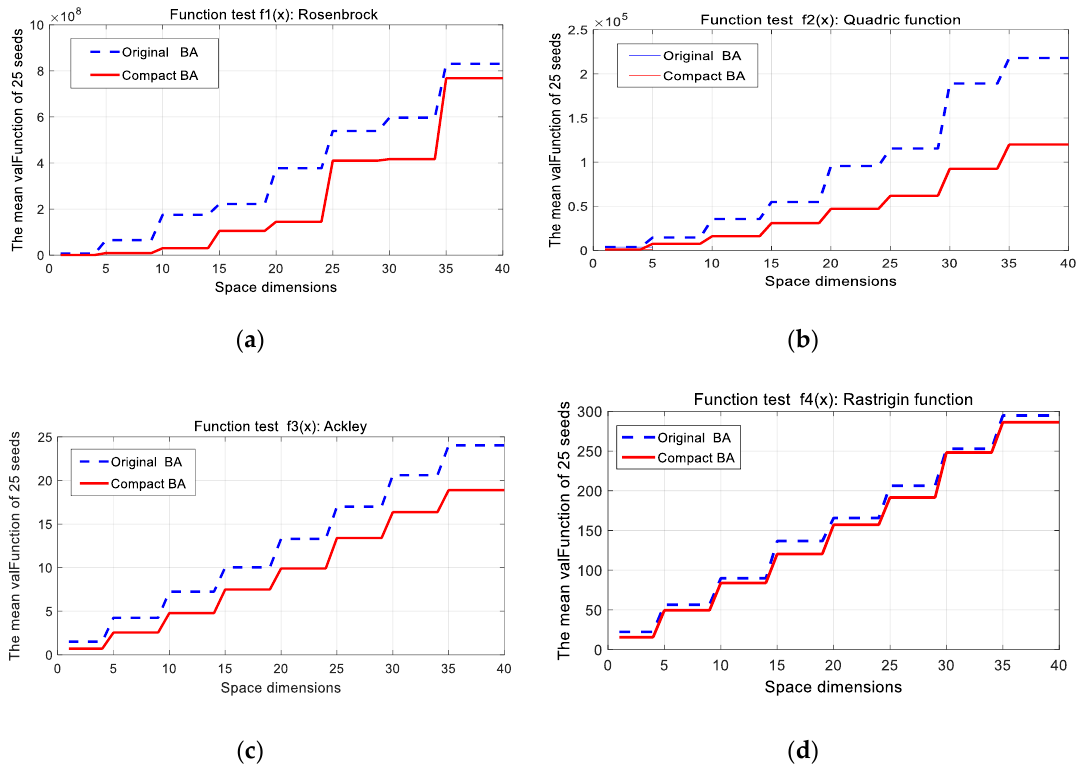
Figure 2. Comparison of two curves with affected variety of the population size in BA and compact BA for four first test functions. ( a ): Rosenbrock function; ( b ): Quadric function; ( c ): Ackley function; ( d ): Rastrigin function.